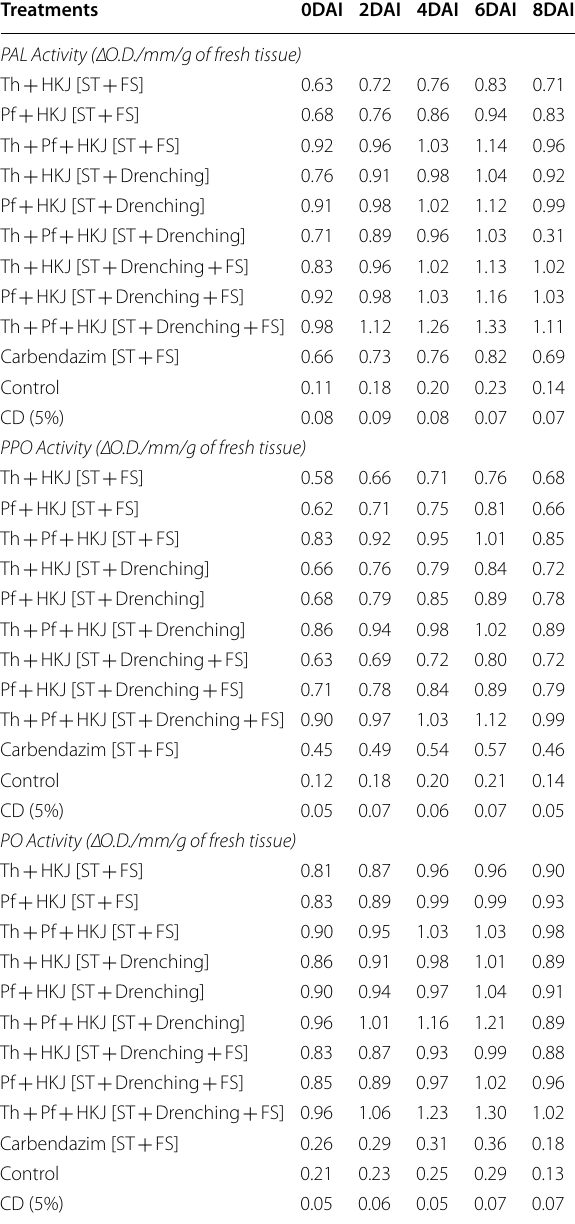
Table 4 Phenylalanine Ammonia Lyase (PAL), Polyphenol Oxidase (PPO) and Peroxidase (PO) activity in rice plants against the sheath blight pathogen Rhizoctonia solani through the different combination of biocontrol agents and Herbal Kunapajala